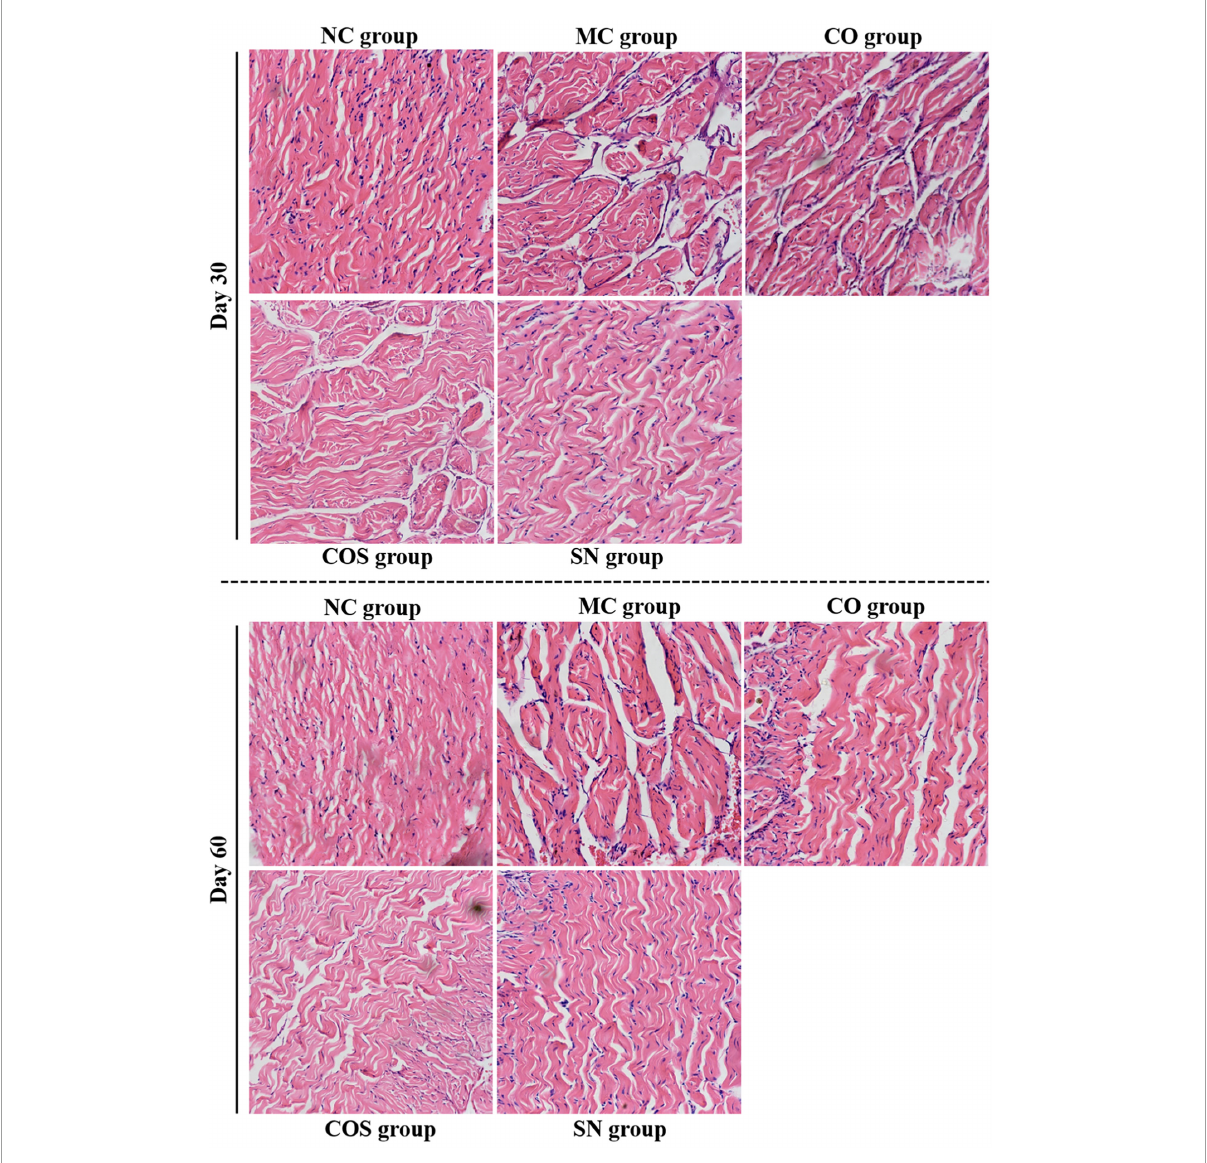
FIGURE5 Penis histomorphologies of hyperlipidemia-induced reproductive damage rats. Photomicrographs of penis tissue sections stained with hematoxylin and eosin (H&E) ( × 200). NC, normal control; MC, model control; CO, Camellia oil; COS, Camellia oil + squalene; SN,